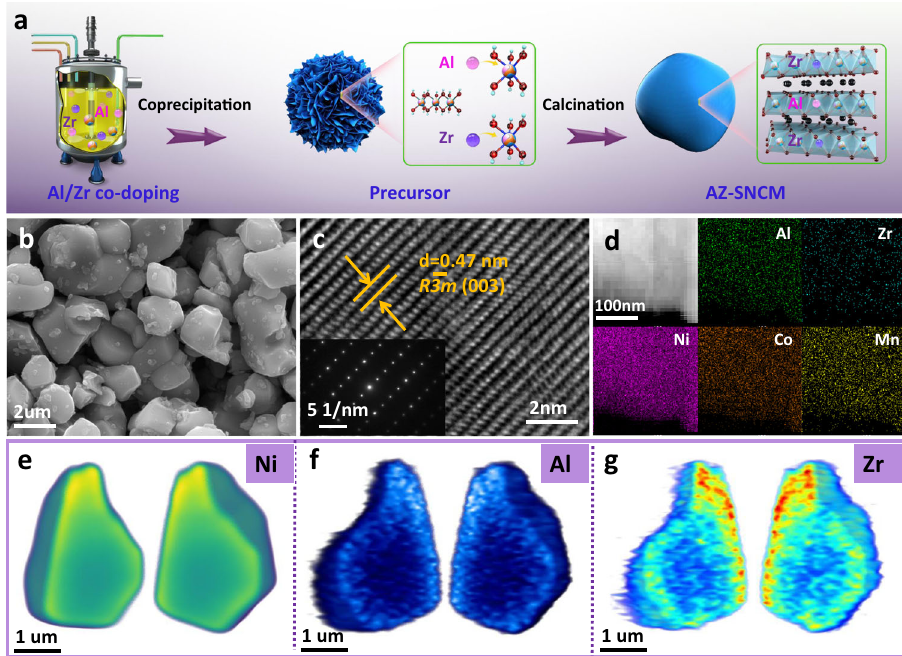
Fig. 1 Synthetic process, morphology, and chemical composition of the AZ0.3-SNCM. a Schematic illustration of the synthesis process of AZ0.3-SNCM. SEM ( b ), HRTEM ( c ) images and SAED pattern (inset) for AZ0.3-SNCM. EDS elemental mappings of Ni, Co, Mn, Al, Zr, and O elements ( d ). Mesoscale element heterogeneity revealed by nano-resolution 3D X-ray fl uorescence. The 3D spatial distribution of Ni ( e ), Al ( f ), and Zr ( g ) in the AZ0.3-SNCM single